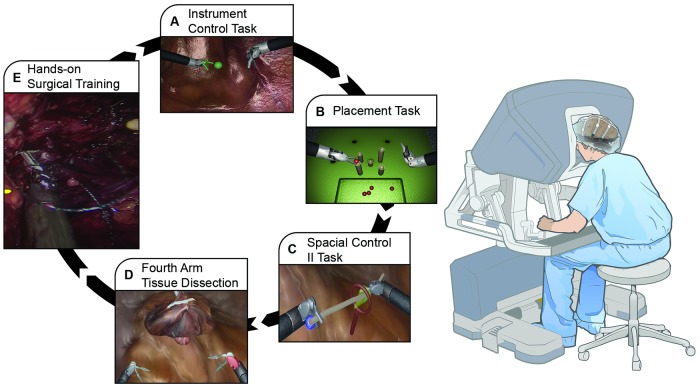
Illustration of experimental set up and schematic of RAS tasks included in this study to acquire skills related to human-machine interface.A 20-channel EEG headset was used to record trainee’s brain activity while performing tasks. Four surgical tasks were designed using Fundamental Skills of Robotic Surgery (FSRS) curriculum: (A) Instrument control task, (B) Placement Task, (C) Spatial control II task, (D) Fourth arm tissue dissection. (E) Hands-on surgical task performed by subjects on Robotic Surgery Simulator (RoSS).